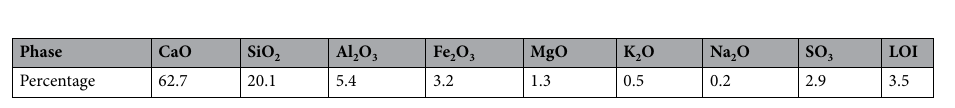
Table 2. Chemical composition (wt%) of the OPC used in this